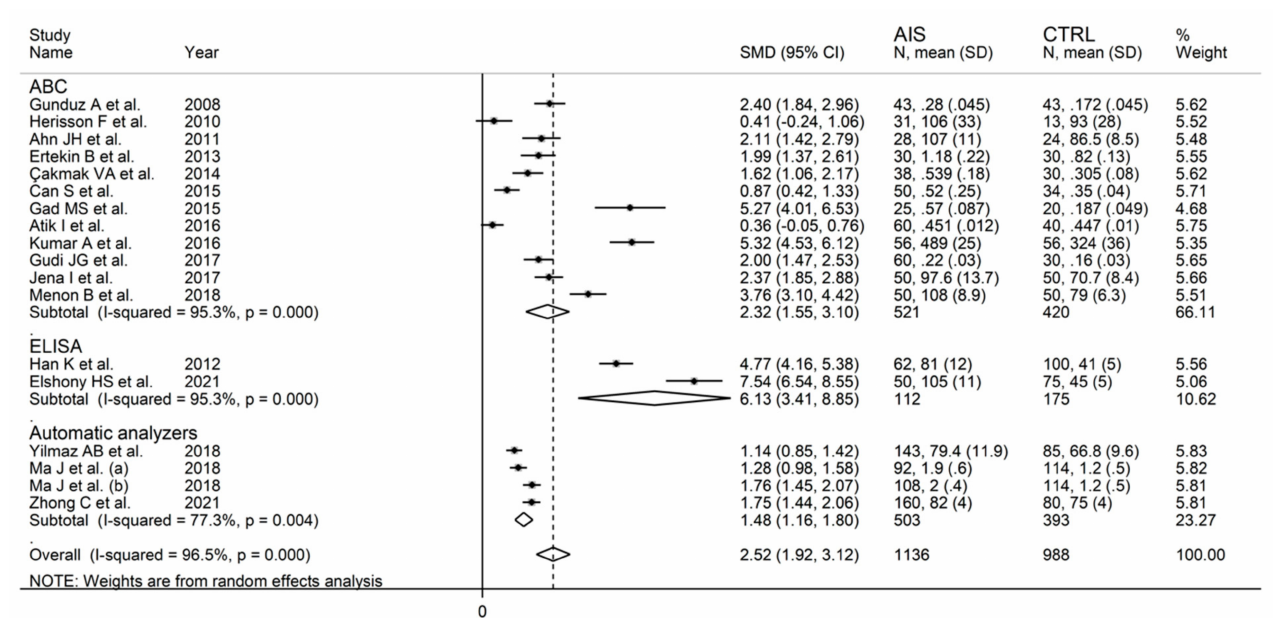
Figure 7. Forest plot of studies examining ischaemia-modified albumin in acute ischaemic stroke according to the assay